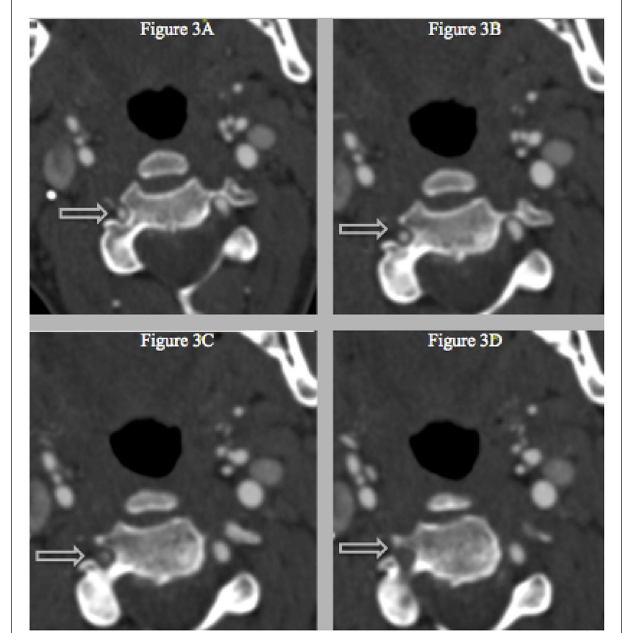
FIgURe 3 | (a–D) Successive CT with IV-contrast images (0.75 mm) depicting a segment of non-opacification within the right vertebral artery and a normal vertebral canal at level C3, which suggests that the stenosis is not related to vascular hypoplasia within that area.